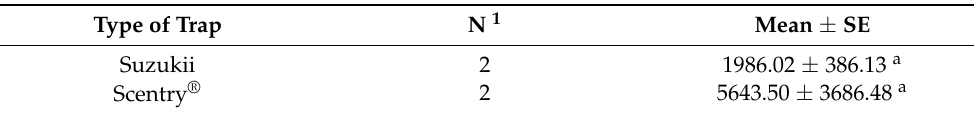
Table 7. Comparative trap catches of adult D. suzukii on blueberries using Suzukii traps and Scentry ® traps in 2017 and